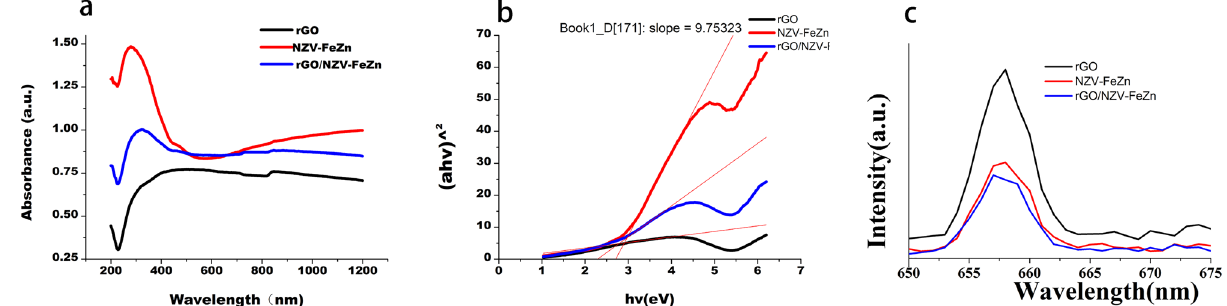
Figure 11. ( a ) Figure 11. a, UV-vis diffuse reflectance spectra ,b, (ahν)2-hν curves and c, Pl of rGO, NZV-FeZn, and rGO/NZV-FeZn. UV–vis diffuse reflectance spectra and ( b ) ( ahν ) 2 - hν curves of rGO, NZV-FeZn, and rGO/ NZV-FeZn.